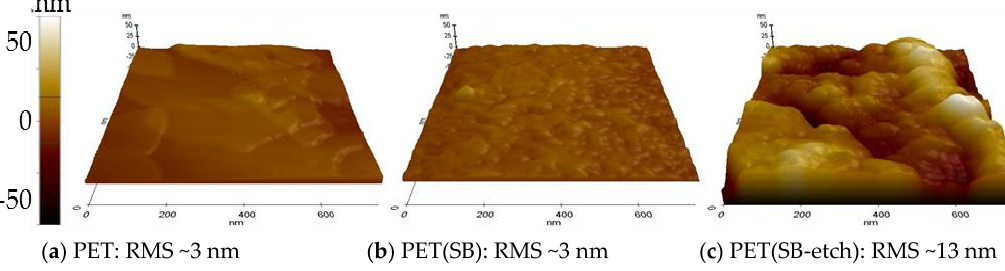
Figure 6. Scanning electron microscopy (SEM) images of surfaces. Inserts are optical microscope images with the scale bar of 1 mm.